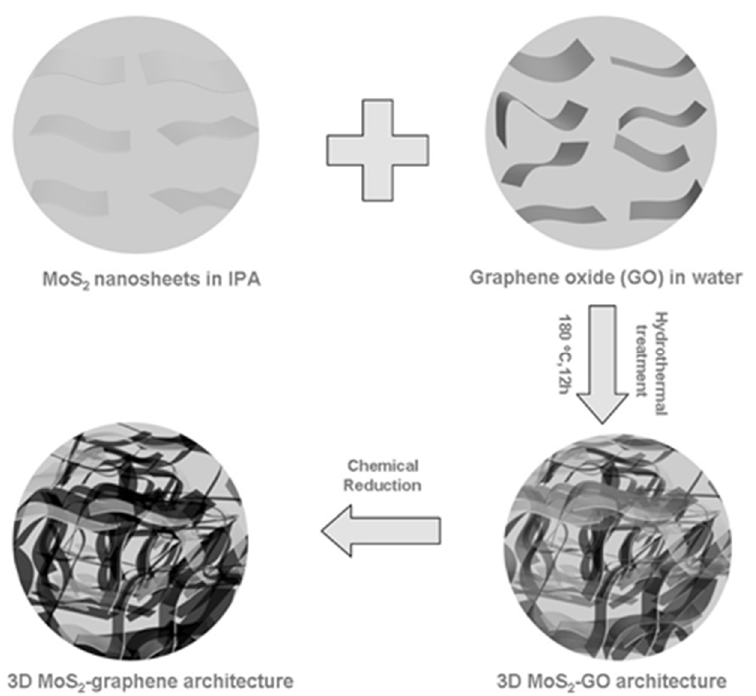
Figure 4. Schematic illustration for the construction of 3D MoS 2 -graphene architectures. It mainly involves three steps: (1) fabrication of MoS 2 and graphene oxide nanosheets via liquid exfoliation and Hummers methods, respectively; (2) hydrothermal treatment of the mixed dispersion of MoS 2 and GO nanosheets in IPA (isopropyl alcohol)/water (1:2, v / v ) at 180 ◦ C for 12 h; (3) chemical reduction of GO to generate 3D MoS 2 -graphene architectures. Reproduced with permission of ref. [111].